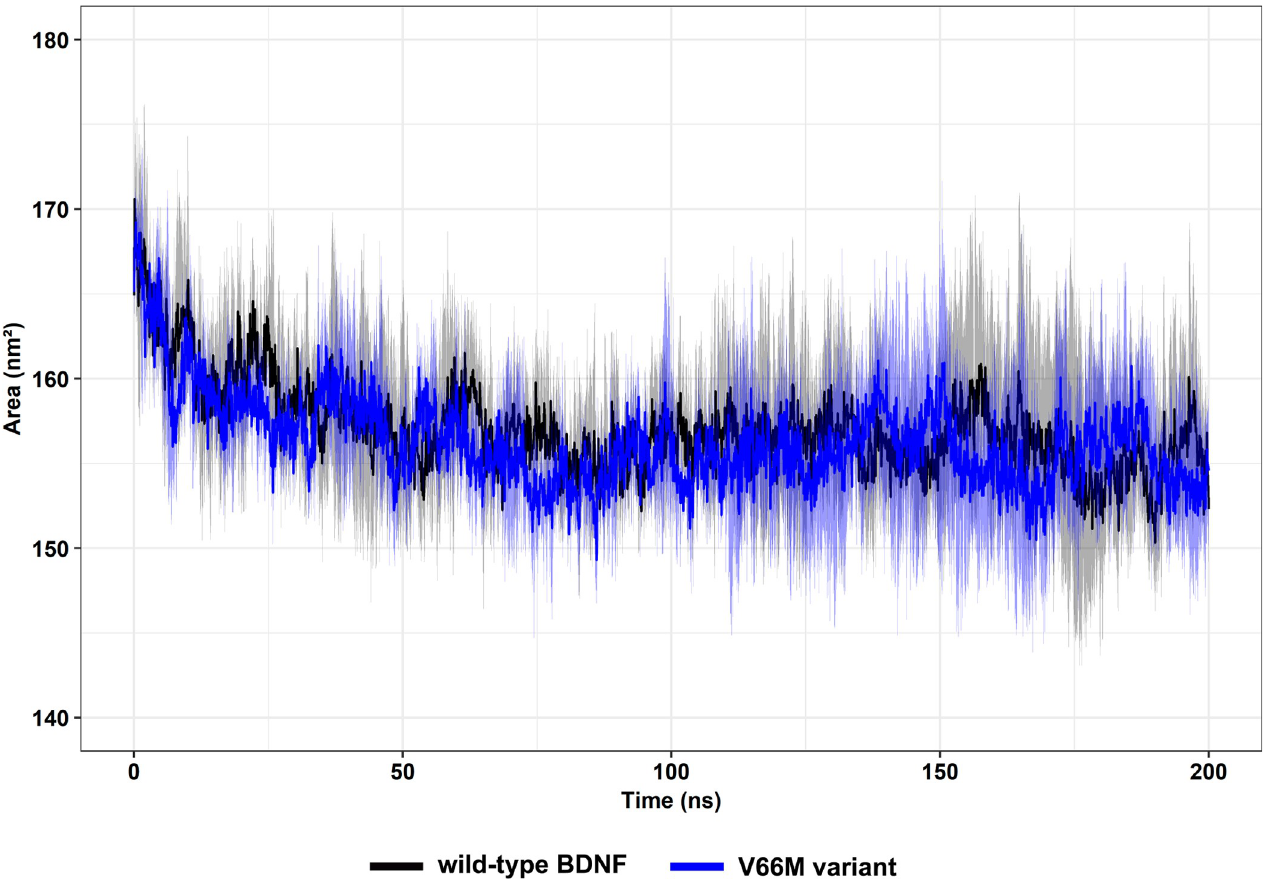
Fig 14. SASA of wild-type BDNF and its V66M variant. SASA of wild-type BDNF (black) and its V66M variant (blue) are shown as a function of time. Mean (solid lines) and confidence interval (smooth lines) of the replicates are displayed.